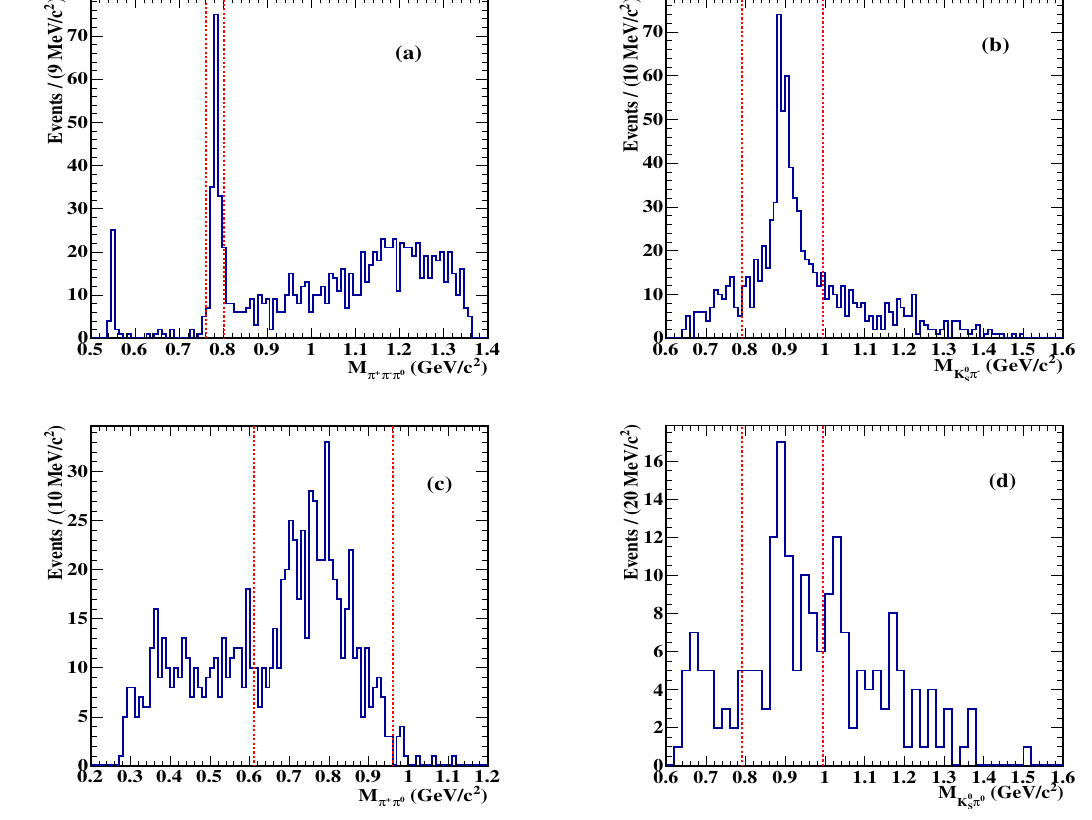
Figure 10 . Invariant mass distributions for (a) (cid:25) + (cid:25) (cid:0) (cid:25) 0 , (b) K 0 of D ! K 0 (cid:25) + (cid:25) (cid:0) (cid:25) 0 decays tagged by K (cid:6) e (cid:7) (cid:23) . Candidates from the pervious bins are removed S sequentially in the order given in table 6: (a) no events removed, (b),(c) events in bin 1 and (d) events in bins 1 to 5 removed. The vertical dotted lines indicate the selected mass windows for the ! , K (cid:3) and (cid:26) resonances,